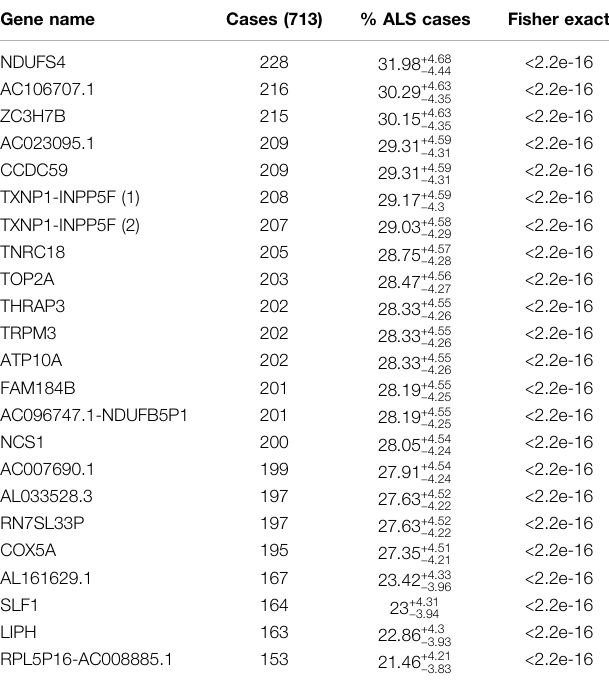
( Table 1 ). Top variants of interest and their signi fi cance are